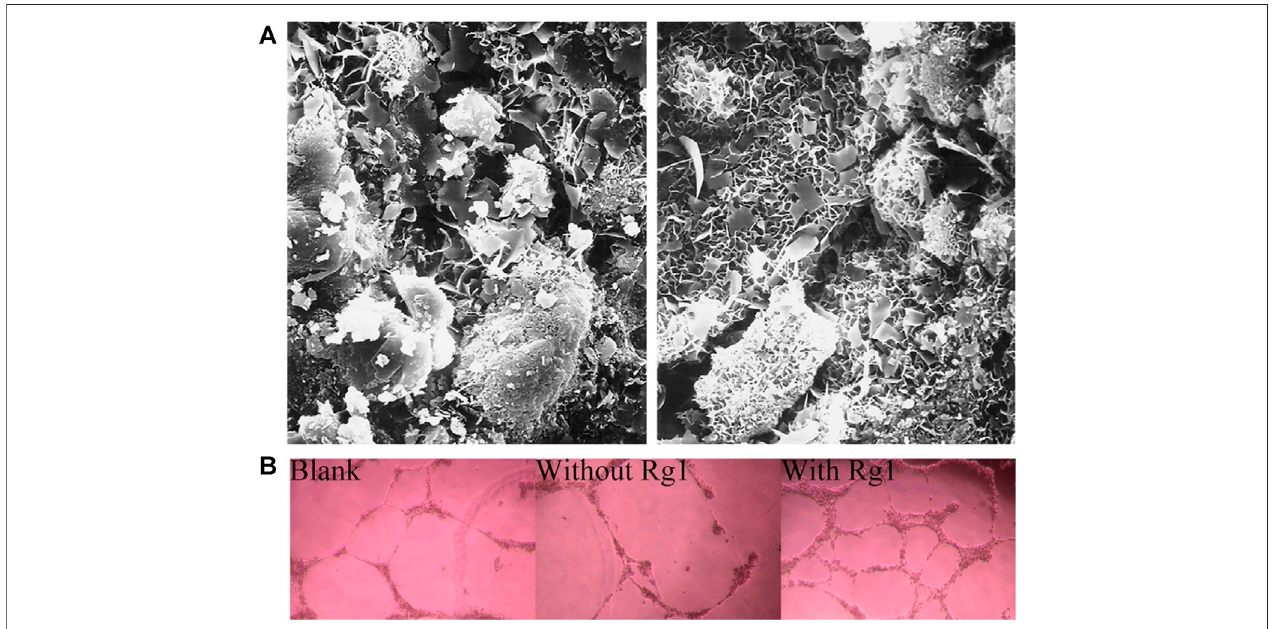
FIGURE 9 | The bone cement composite material added with ginsenoside Rg1 to treat osteonecrosis. (A) Section morphology observation of the cement in different C/P ratio by scanning electron microscopy. (B) Tube formation in different extract-contained media from cements. Reproduced with permission (Chang et al., 2010). Copyright 2010, Elsevier